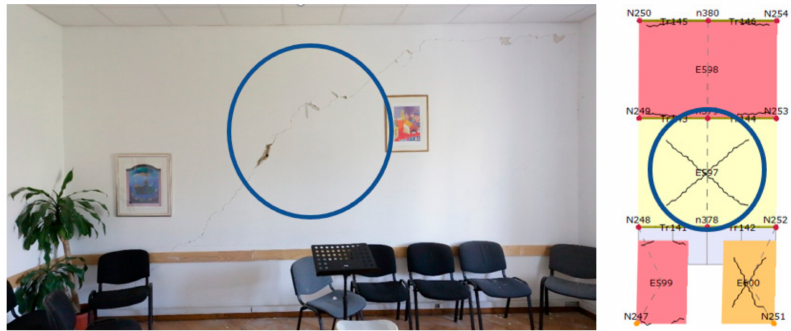
Figure 27. Comparison of the damaged bearing wall in the y